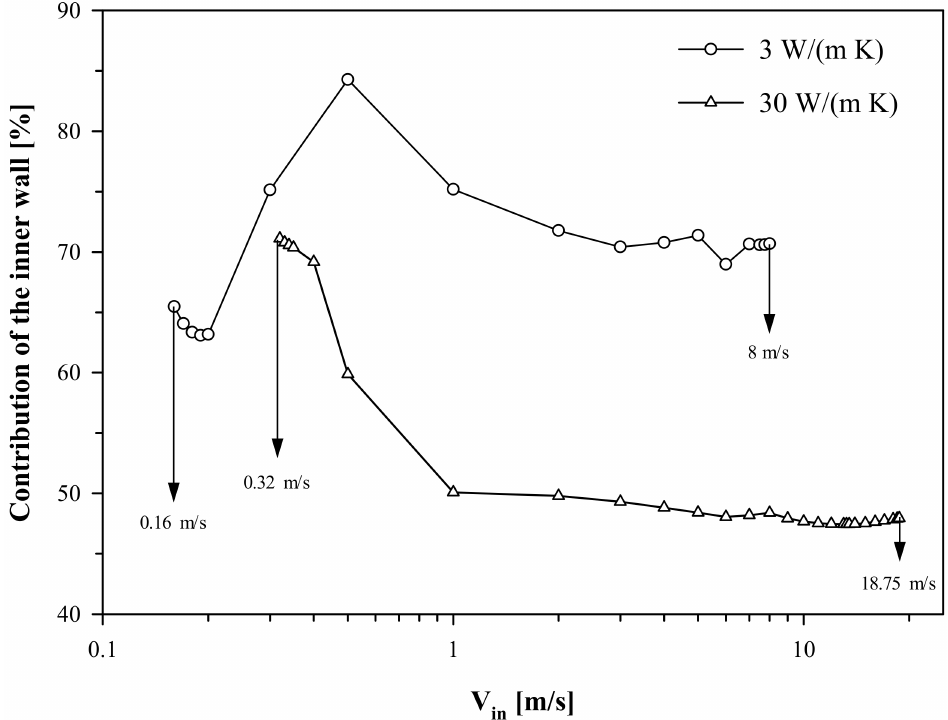
Figure 12. Contribution of the inner wall to the catalytic conversion of propane as a function of V in for reactor configuration (A) Both walls catalytic of Figure 1. Low thermal conductivity (3 W/(m K)) and high thermal conductivity (30 W/(m K)). Arrows indicate extinction (at low values of V in ) and blowout (at high values of V in